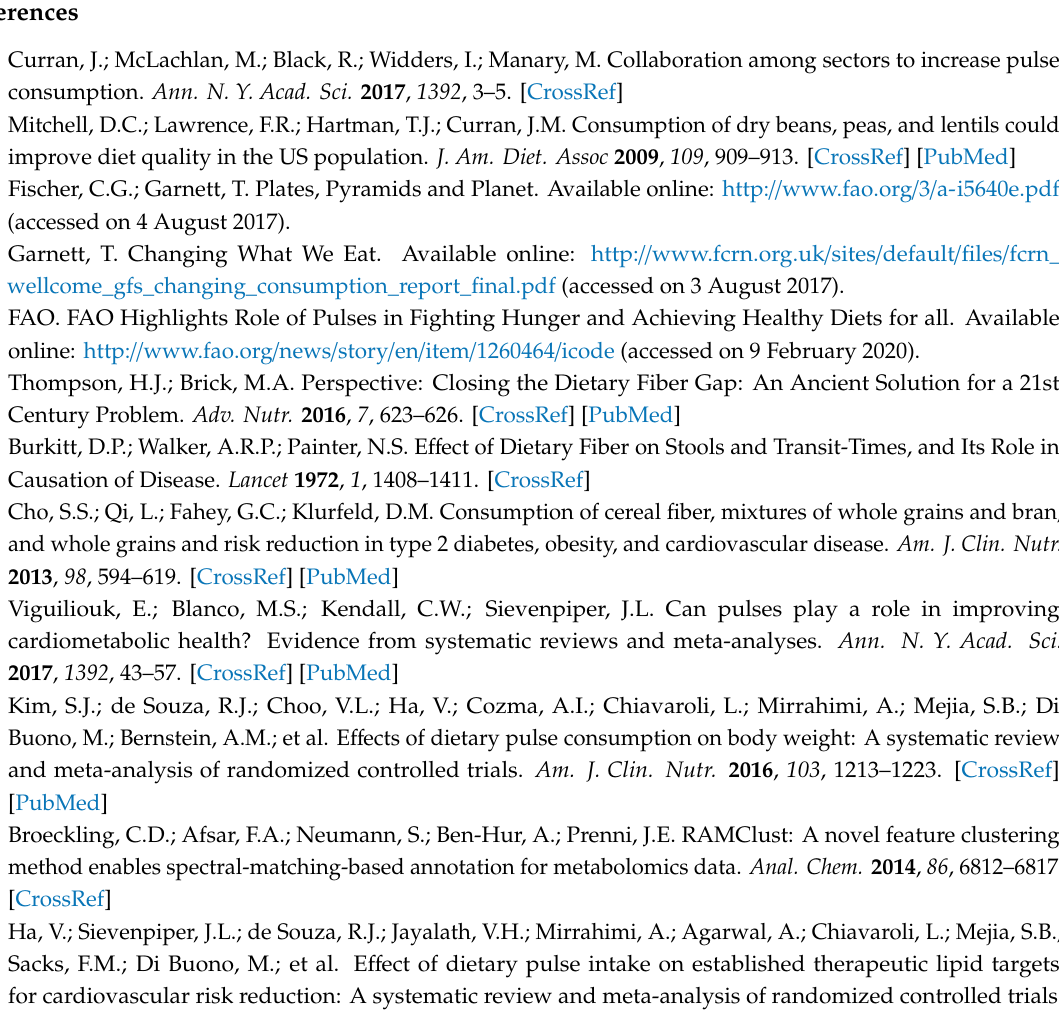
Figure S1: Intestinal tissue in high-fat control, Table S1: Composition of experimental diets, Table S2: Pulse food composition data, Table S3: qPCR Gene expression primers and bacterial primers, Table S4: E ff ect of feeding of pulses on intestinal alcian blue stained mucin, Table S5 E ff ect of feeding of pulses on intestinal cell proliferation, Table S6: Metabolites that discriminate pulse types, and Table S7: Metabolite